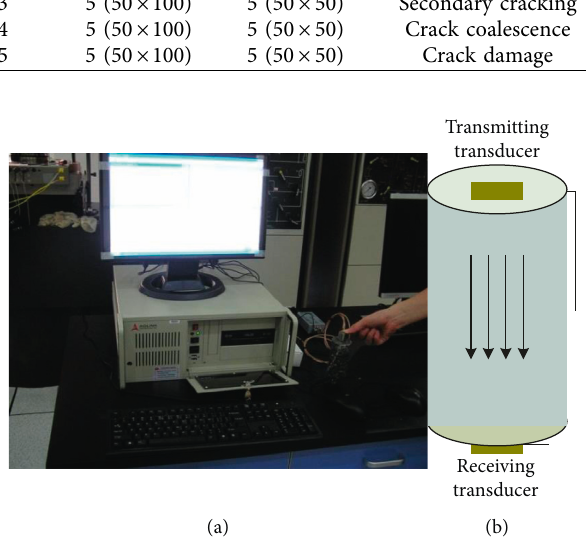
Figure 2: Schematic diagram of P-wave velocity test on rocks. (a) Laboratory P -wave velocity test. (b) P -wave velocity propaga- tion diagram.